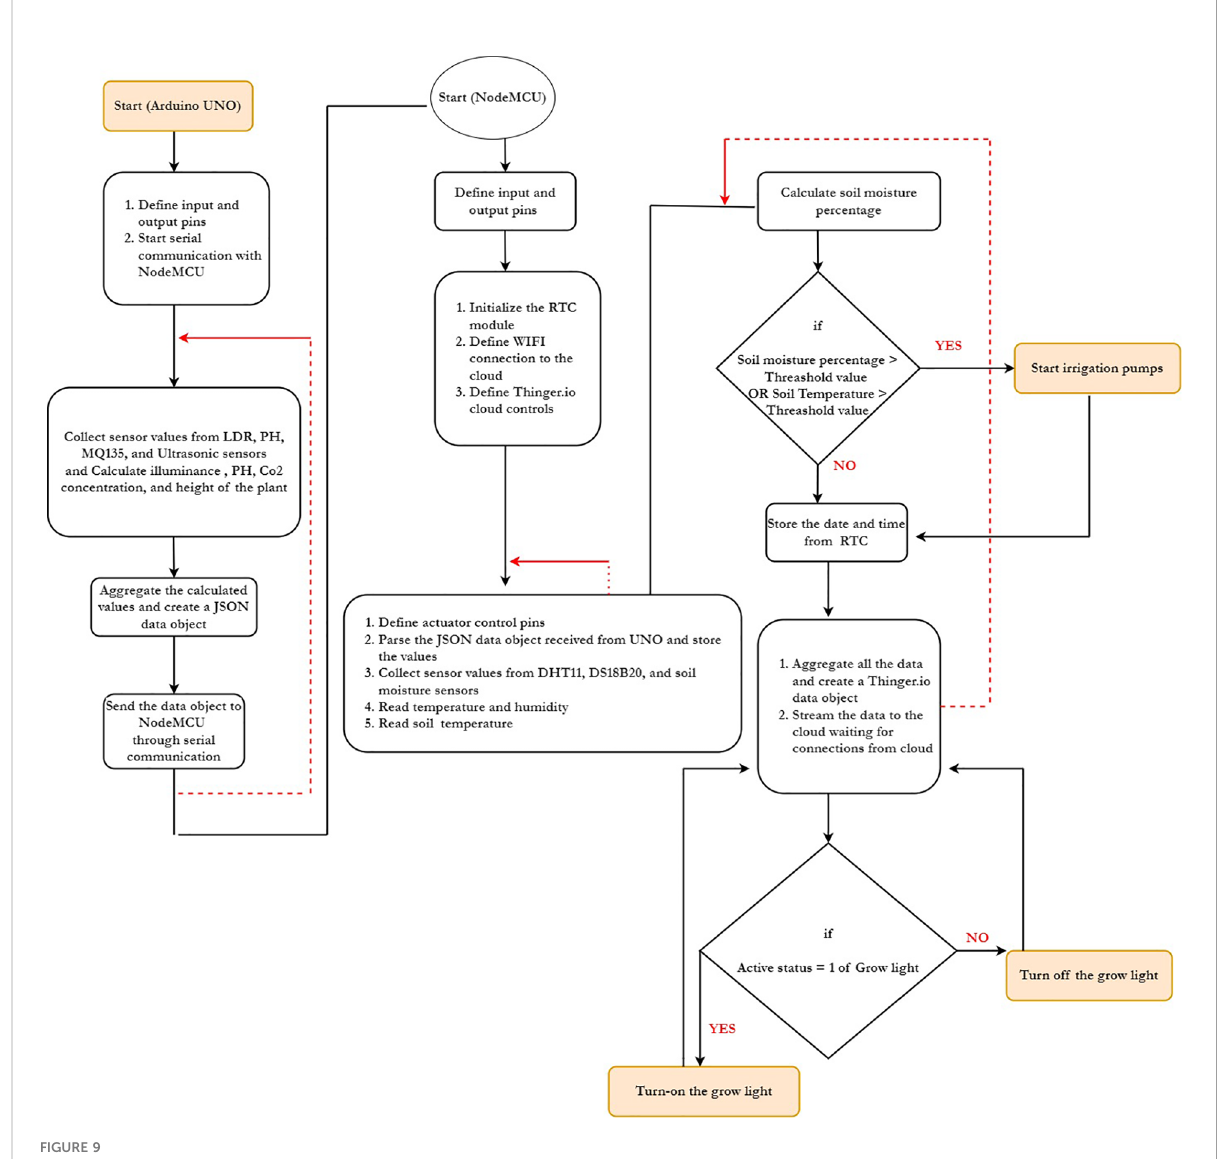
FIGURE 9 The work fl ow of our